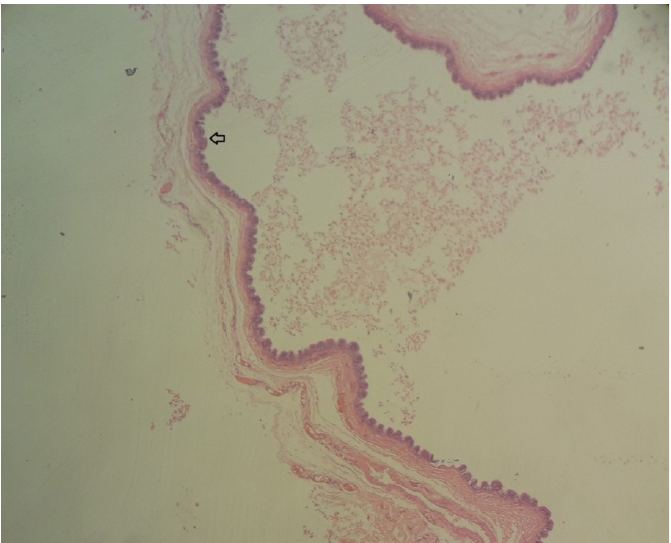
Figure 3(a): Histopathological section of Bronchogenic cyst: Psudostratifiedcolumnar ciliated epithelium lying on a fibro-muscular wall.